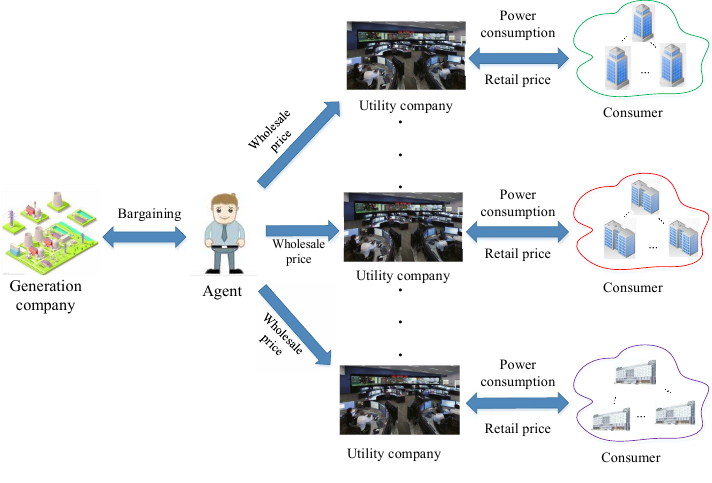
Figure 1. An electricity